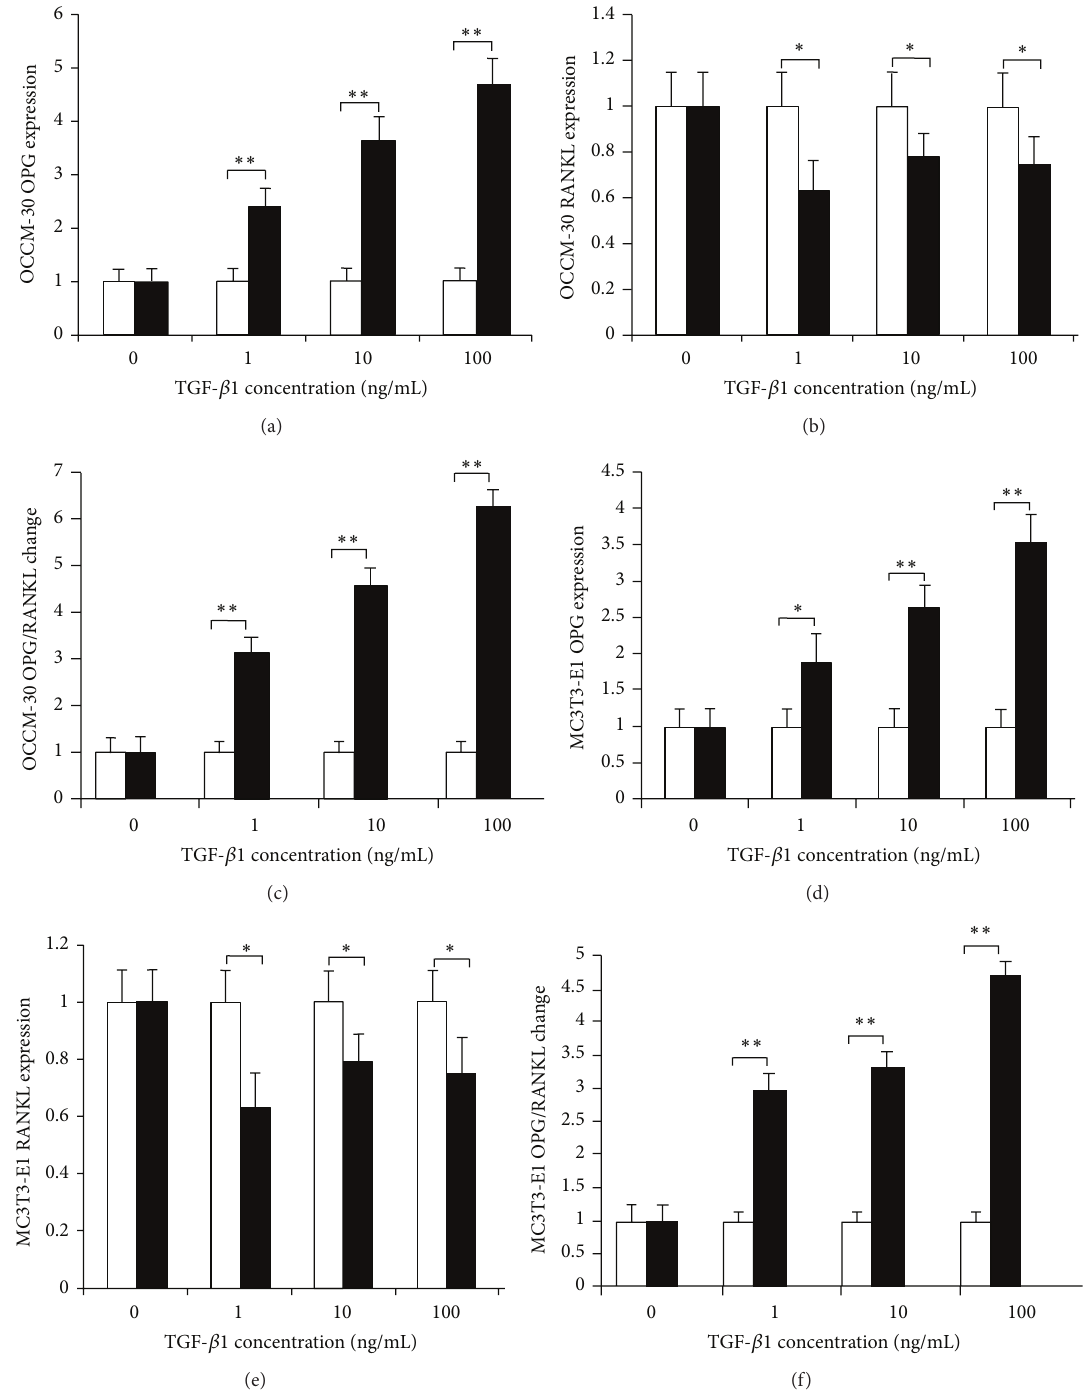
Figure 5: Effects of TGF- 𝛽 1 on cementoblasts and osteoblasts without mechanical stress.